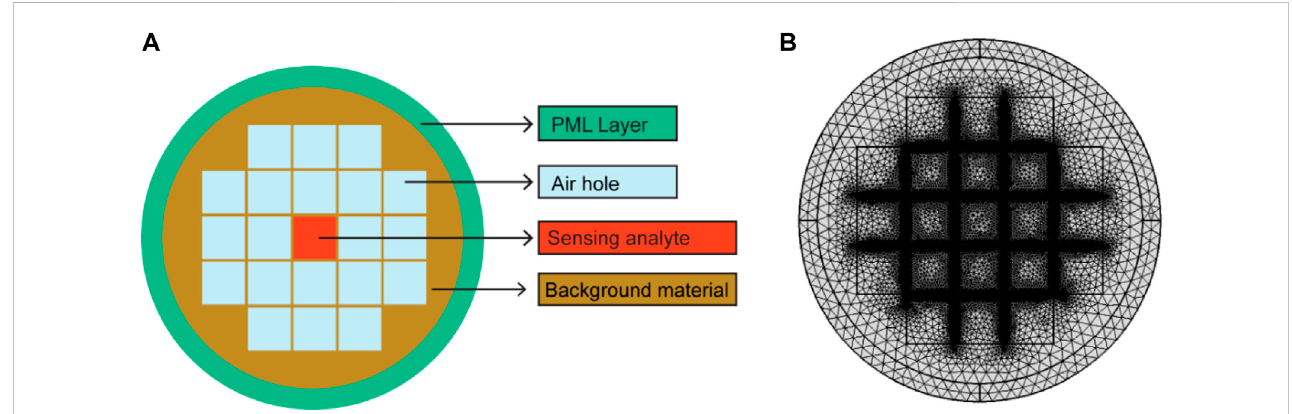
Cross-sectional view and meshing view of the PhCF sensor. (A) Cross-sectional details. (B) Meshing